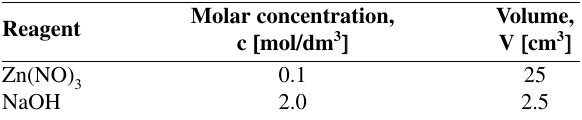
Table 1. Substrates used in the precipitation process Molar concentration, Volume, Reagent